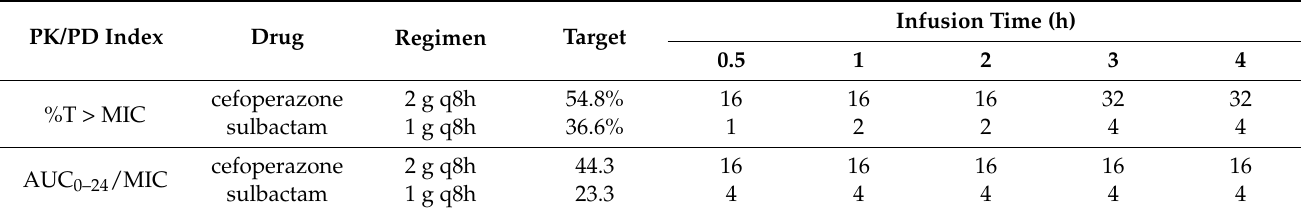
Table 4. PK/PD cutoff based on PK/PD index for a single drug